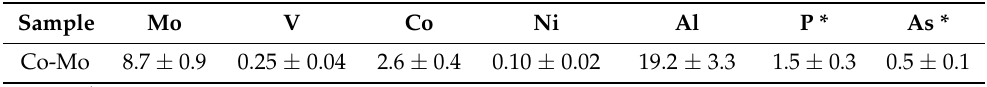
Table 1. The concentration of metals in the spent unroasted catalyst (%wt, average values). Sample